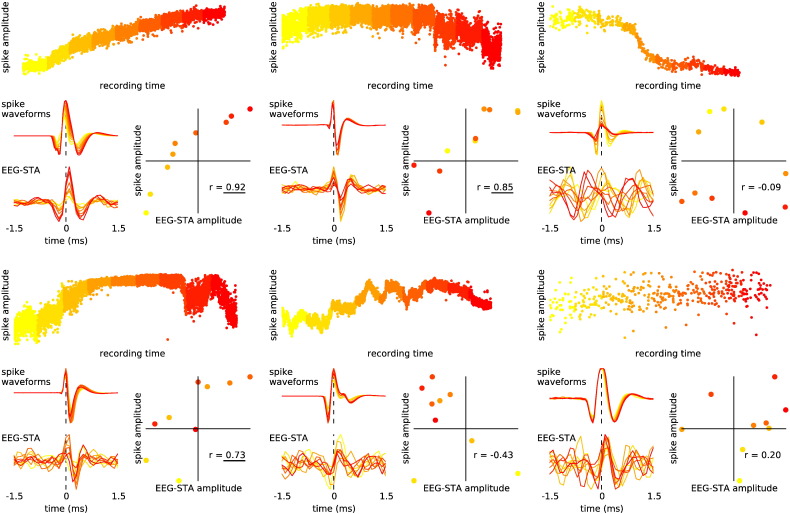
Co-variability of spike and EEG-STA amplitude over time. Each of the 6 panels represents the analysis of a single cell (order as in Fig. 2c). In five of these six cells the spike amplitude varied slowly over time (top) probably reflecting recovery from cell damage or slow drift of the electrode position. We split all spikes of a cell into 10 equally-sized groups according to the time of their occurrence since the beginning of recording session (marked by colours from yellow to red) and averaged both the spike waveforms and the corresponding spike-triggered EEG segments (bottom-left corner). The scatter plots of the peak-to-peak amplitudes of the averages (bottom-right corners; each point reflects a single average; normalised units) indicate a slight correlation (Pearson's correlation coefficient, r, given on the graph; underlined values denote p < 0.05). This result suggests that the positive correlations observed in Fig. S2 might be induced by the temporal variations of the spike amplitude.